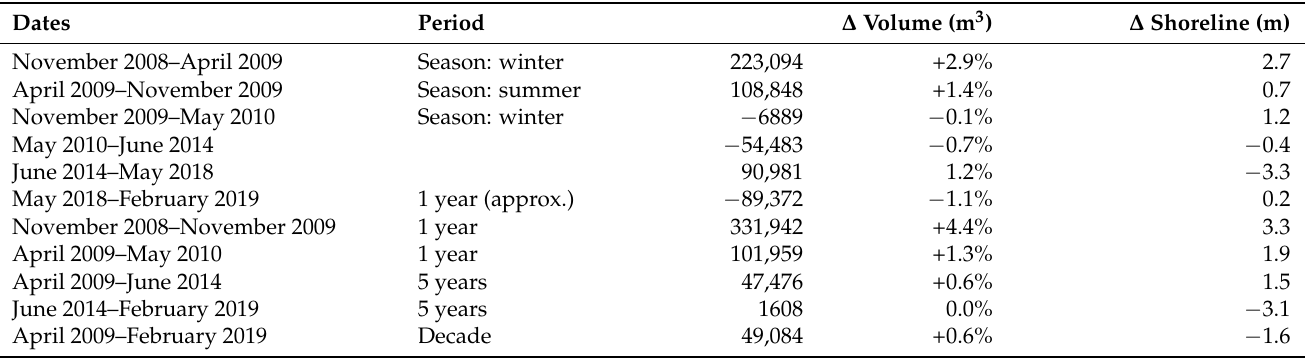
Figure 6. Scheme of the adopted procedure, where digital elevation models (DEMs) and the digital terrain model (DTM) were analysed in terms of the spatial and temporal morphodynamics, which were subsequently related to local features and wave and wind patterns. Table 1. Changes in volume of the beach–dune system and in the shoreline position (positive and negative values indicate seaward and landward movements, respectively) that were observed between subsequent surveys (upper rows), and for the yearly, 5-yearly and the decadal periods of the time series analysed.